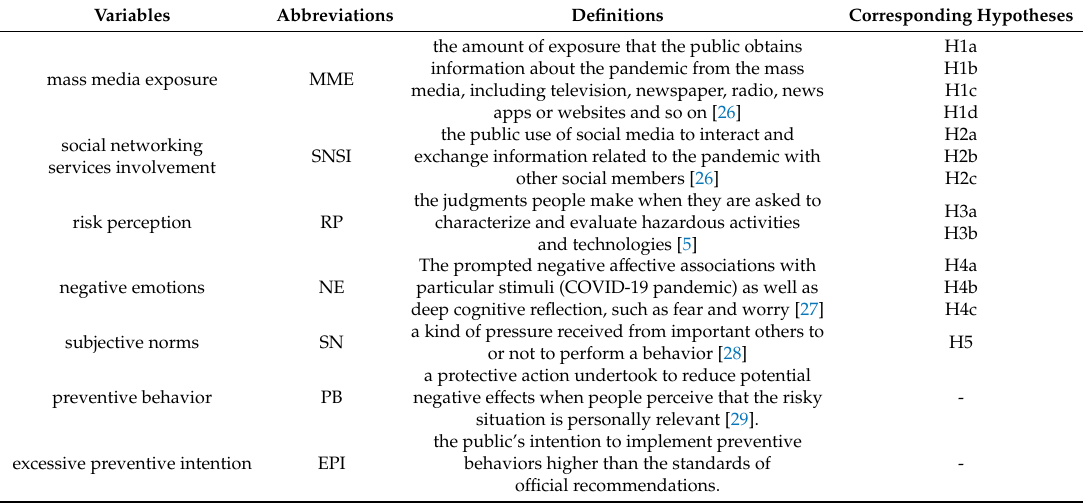
Table 1. Abbreviations, Definitions and Hypotheses of